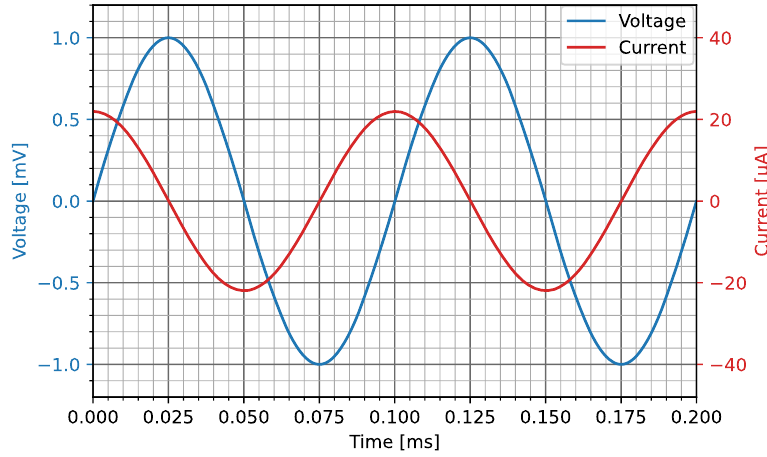
Figure 35. Simulated voltage and current curves (1 mV, 10 kHz input signal applied).